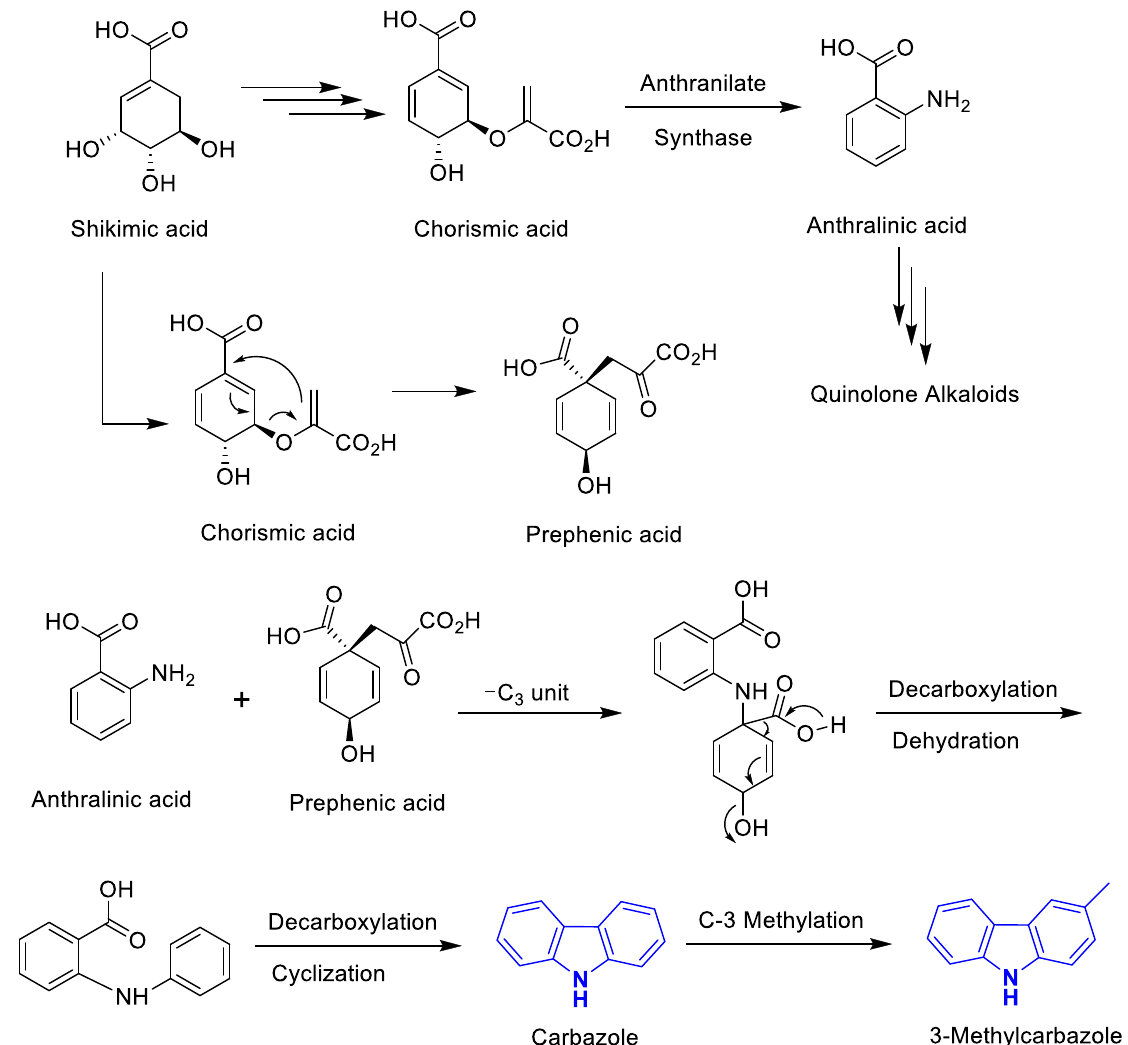
Figure 1. Biogenetic pathway in the formation of carbazole and 3-methyl carbazole alkaloids and core structure of the diverse carbazole alkaloids isolated from nature.